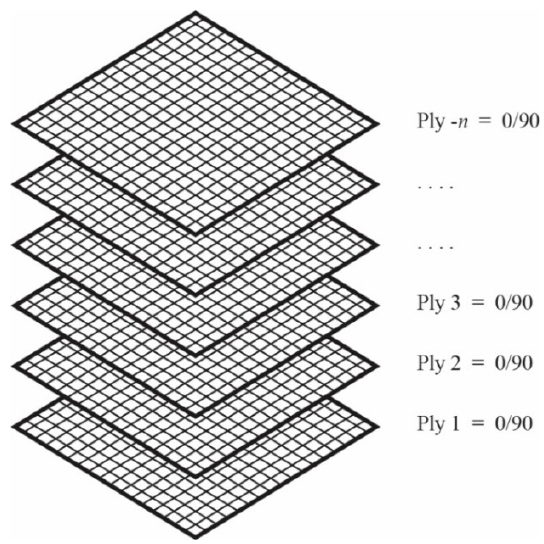
Figure 4. Stacking sequence of carbon fiber.